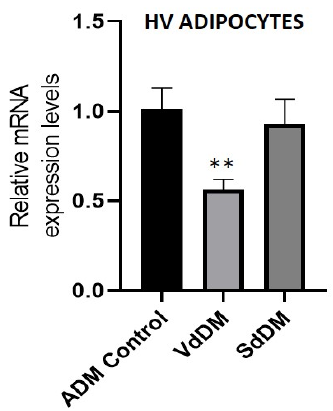
Figure 6. Quantification of PPAR- γ mRNA levels in HV PA differentiated in the presence of VdDM and SdDM. The maximum expression detected for control differentiation (ADM-control) was set at 1. Bars indicate mean ± SEM of relative expression from at least three replicates of each condition. Significant differences are represented as: ** compared to ADM-control, p <